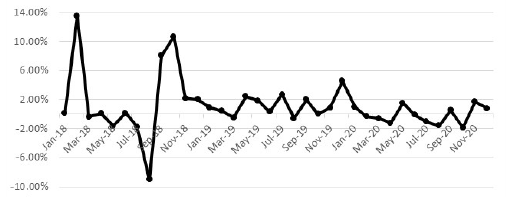
Figure 7. REIF-3 monthly return (%)